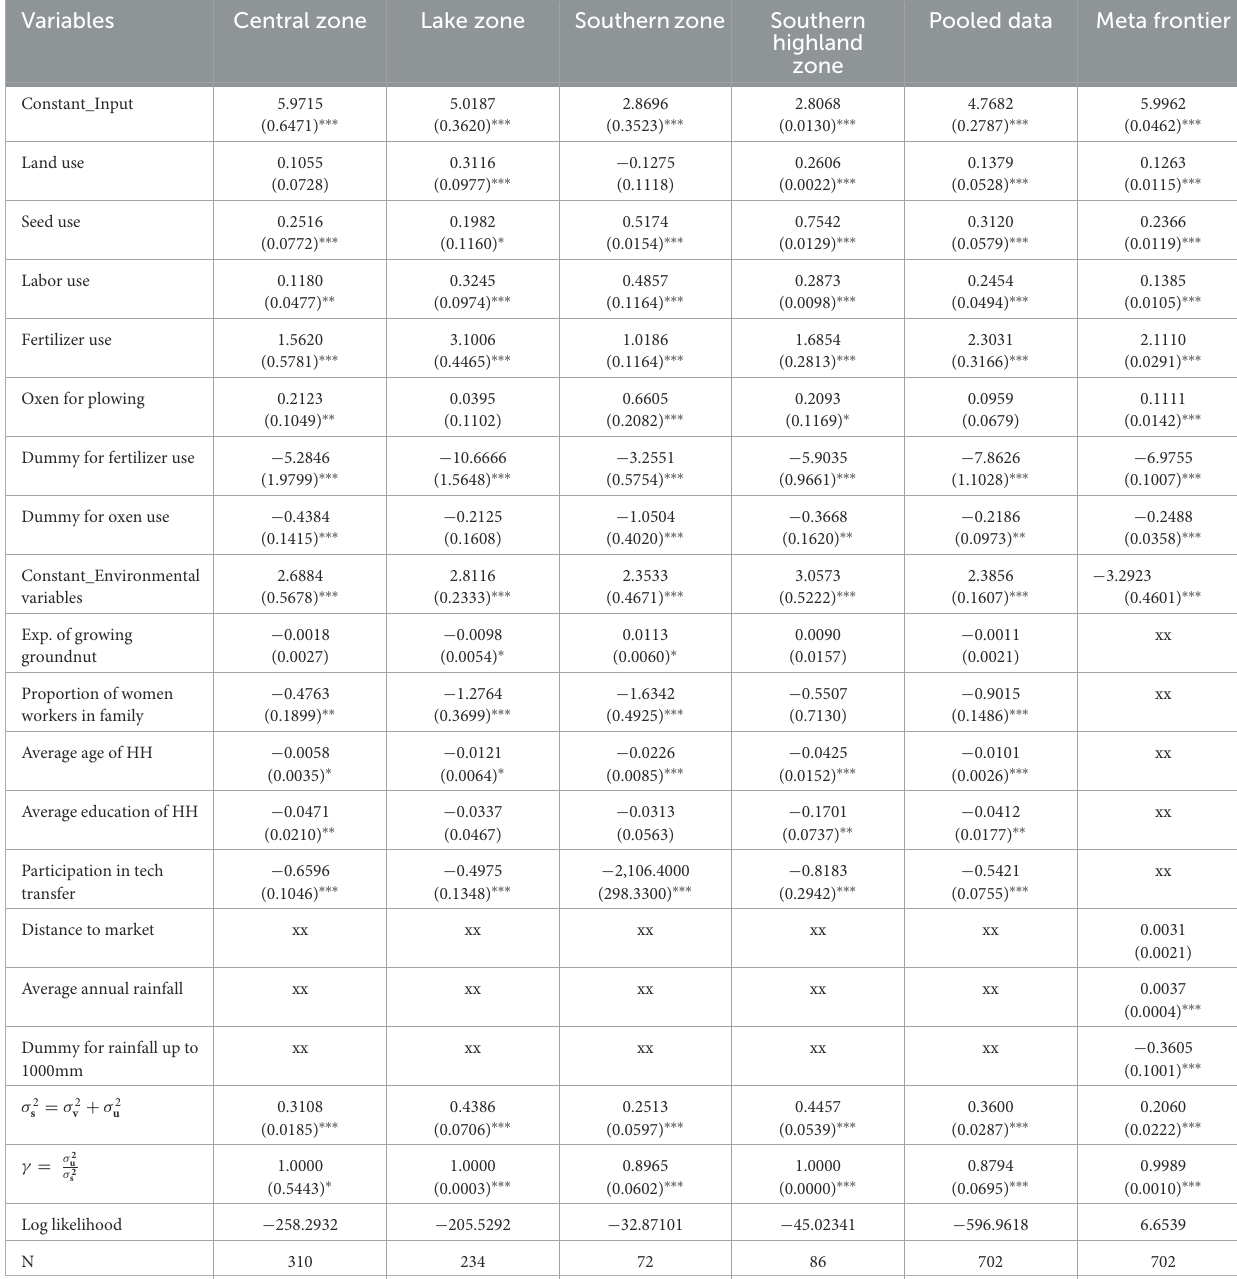
TABLE 3 Region-wise stochastic frontier